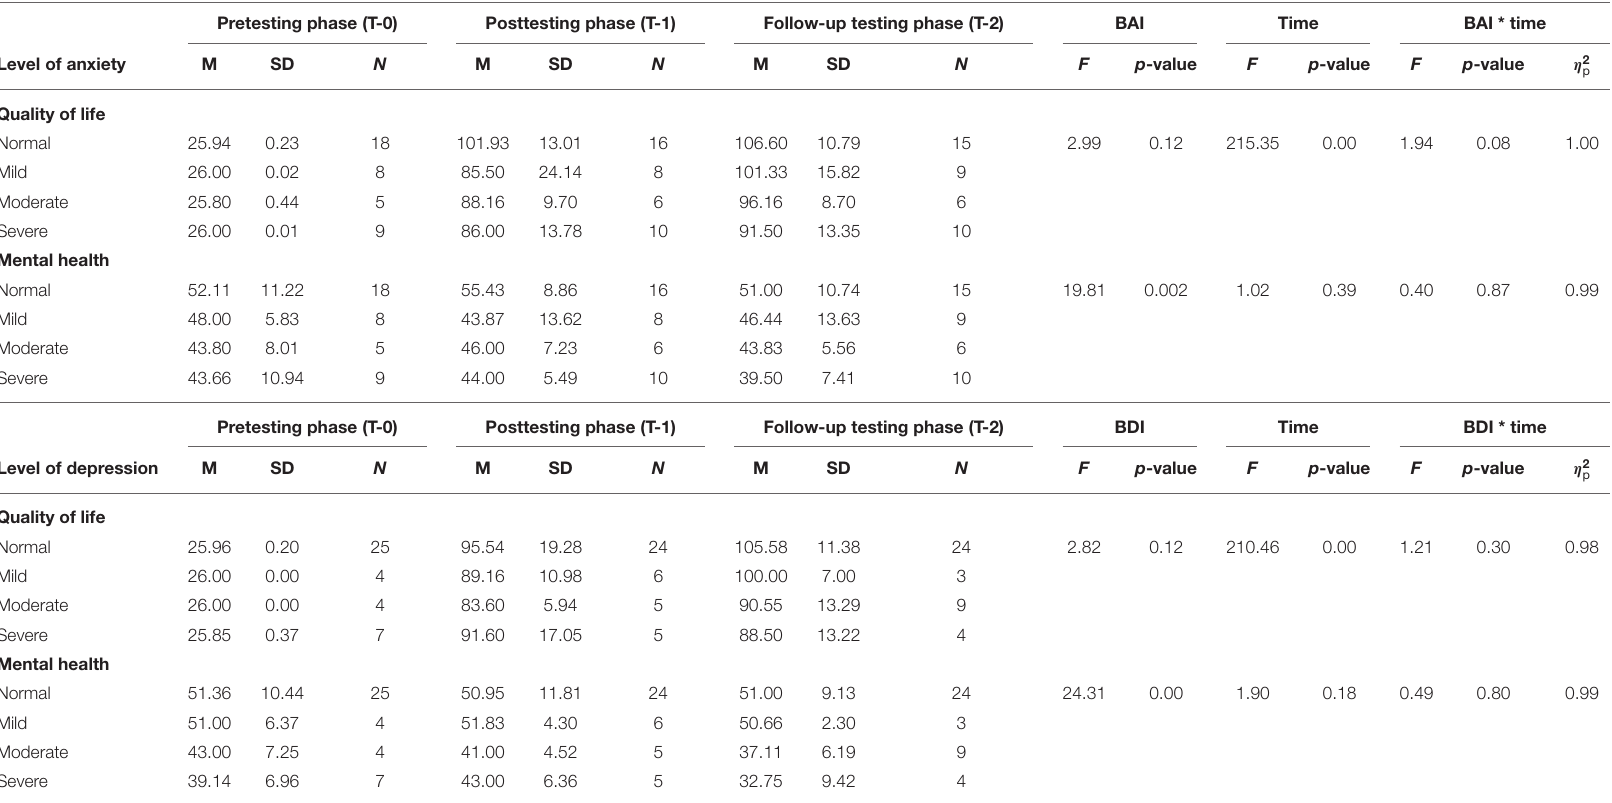
TABLE 3 | Mean difference of quality of life and mental health between pre-testing phase (T-0), post testing phase (T-1), and follow-up phase (T-2) with different level of anxiety and depression in Pakistan students during the COVID-19 epidemic lockdown ( N = 40). Pretesting phase (T-0) Posttesting phase (T-1) Follow-up testing phase